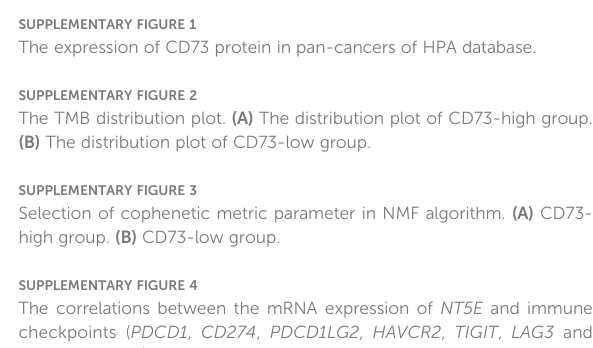
SUPPLEMENTARY FIGURE 1 The expression of CD73 protein in pan-cancers of HPA database. SUPPLEMENTARY FIGURE 2 The TMB distribution plot. (A) The distribution plot of CD73-high group. (B) The distribution plot of CD73-low group. SUPPLEMENTARY FIGURE 3 Selection of cophenetic metric parameter in NMF algorithm. (A) CD73- high group. (B) CD73-low group. SUPPLEMENTARY FIGURE 4 The correlations between the mRNA expression of NT5E and